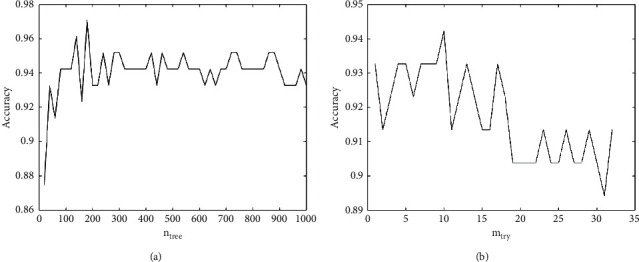
The effect of the two parameters on the performance of RF models: (a) the effect of ntree; (b) the effect of mtry.